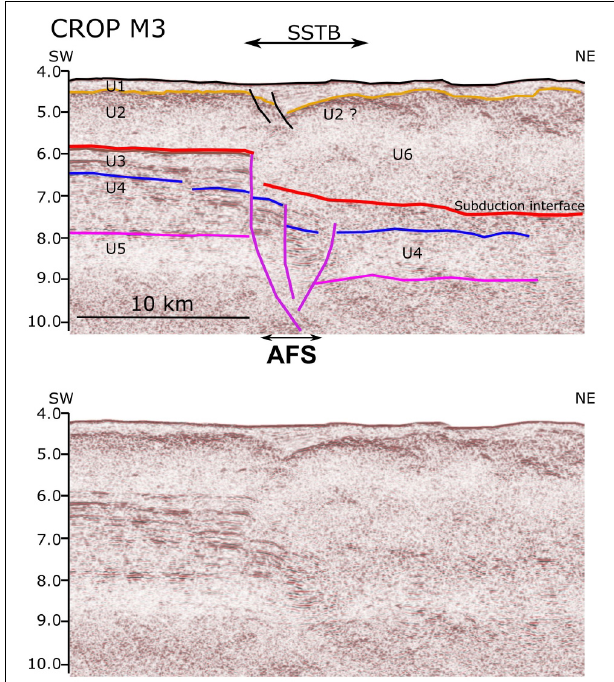
FIGURE 4 | Interpretation of the CROP M3 multichannel seismic profiles across the AFS and showing the Shallow Syn-Tectonic Basin (SSTB), see Figure 2 for location. Data available from CNR-ISMAR